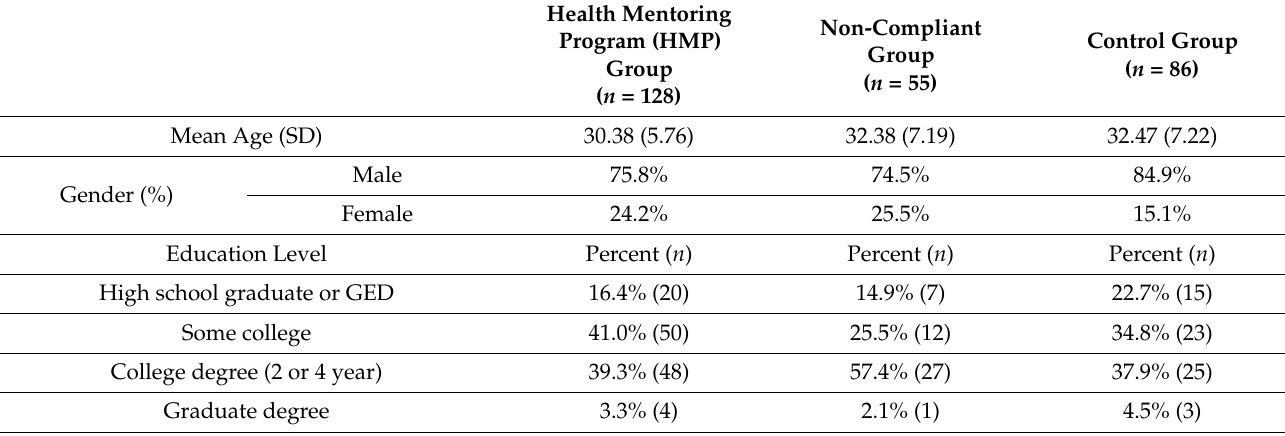
Table 1. Demographics within study groups at baseline ( n =